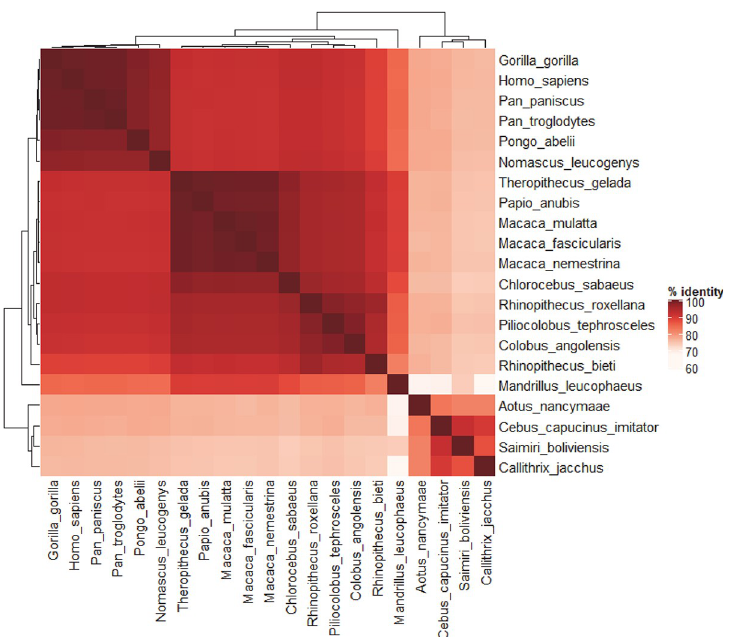
Fig 3. eNEMAL is conserved in primates. Orthologs of the human eNEMAL sequence were queried by BLAST and BLAT searches using NCBI and Ensembl chordate nucleotide databases. Chromosomes or contings that hold the MALAT1 locus were retrieved and aligned. Results with 50% identity over at least 50% of sequence length were considered for orthologs; the only sequences which satisfied these conditions were from primates. Sequences were aligned by MEGA X MUSCLE algorithm and accession numbers for each sequence are provided in S3